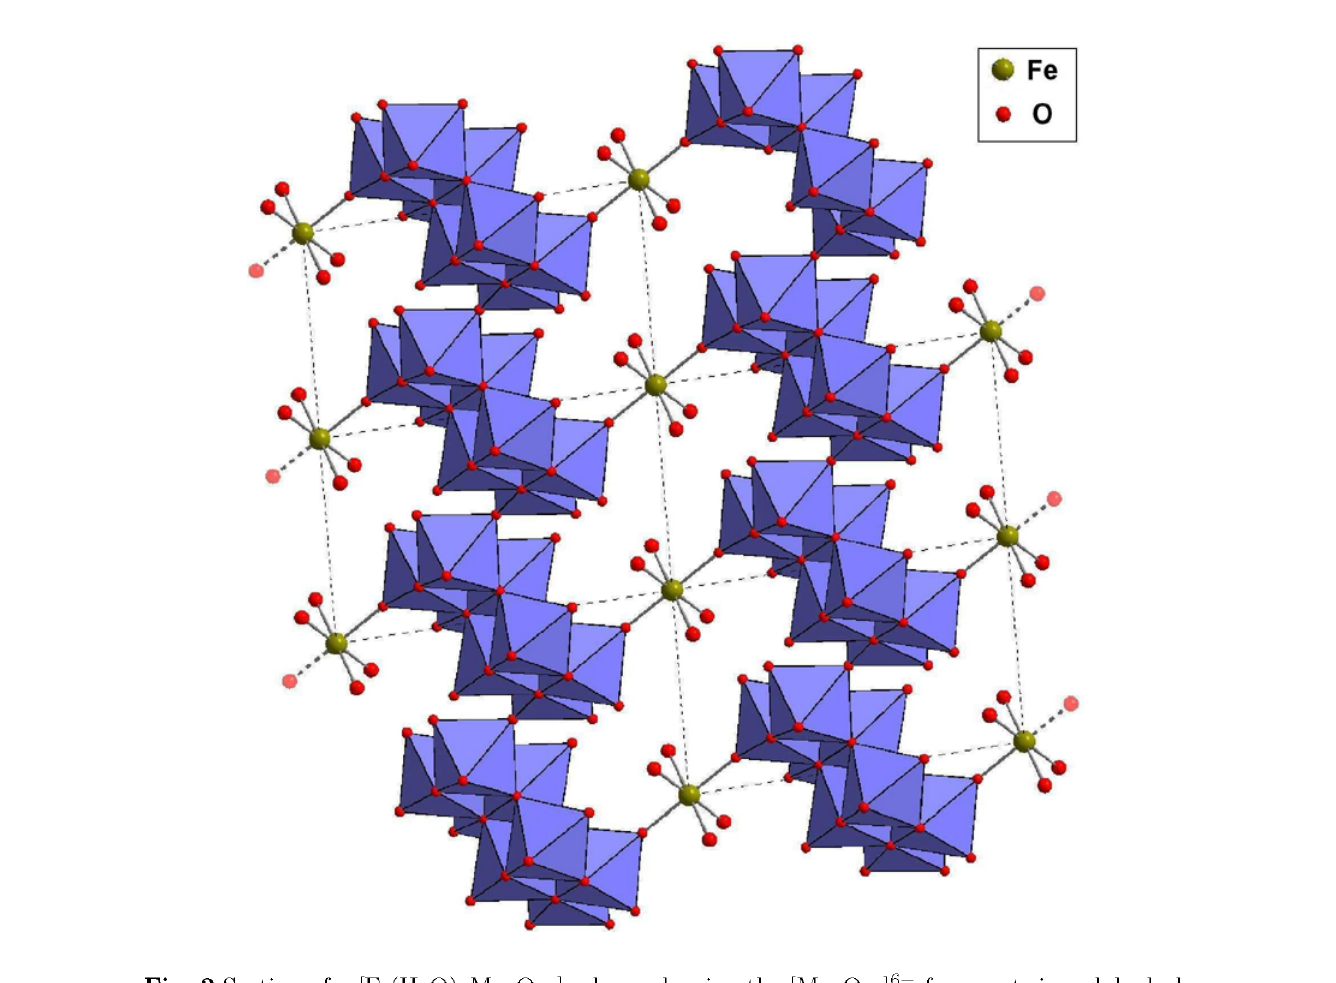
Fig. 2 Section of a [Fe(H20)4MosO27]c~ layer showing the [Mo8027] 6 fragments in polyhedral representation and the octahedral Fe II coordination sphere in ball-and-stick representation. The Fe centers form parallelograms in the ac